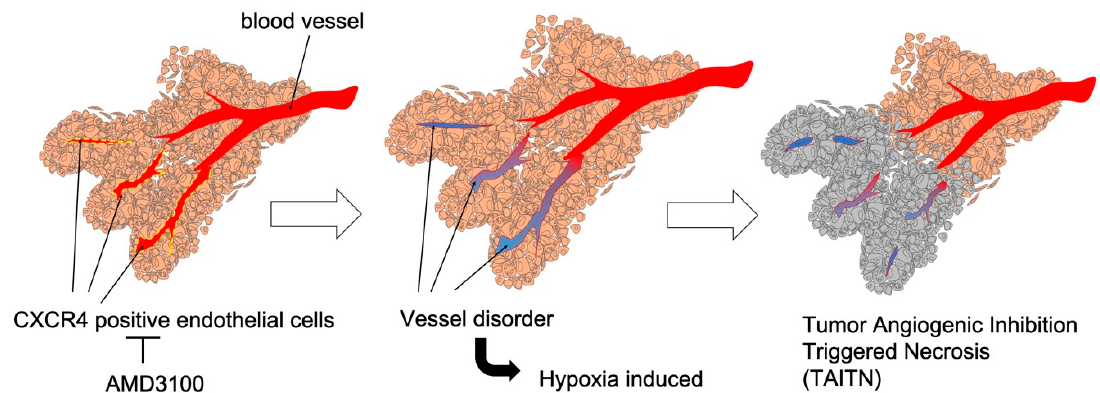
Figure 7. Graphical abstract: CXCR4 antagonism induced tumor necrosis through vessel disorder. Left, a CXCR4 antagonist AMD3100 inhibited CXCR4-positive endothelial cells of tumor vessels. Middle, inhibition of CXCR4-positive endothelial cells induced vessel disorder and caused hypoxia in surrounding tumor cells. Right, necrosis was caused in the surrounding tumor cells through vessel disorder. Taken together, we propose a novel mechanistic concept of “Tumor Angiogenic Inhibition Triggered Necrosis (TAITN)”.